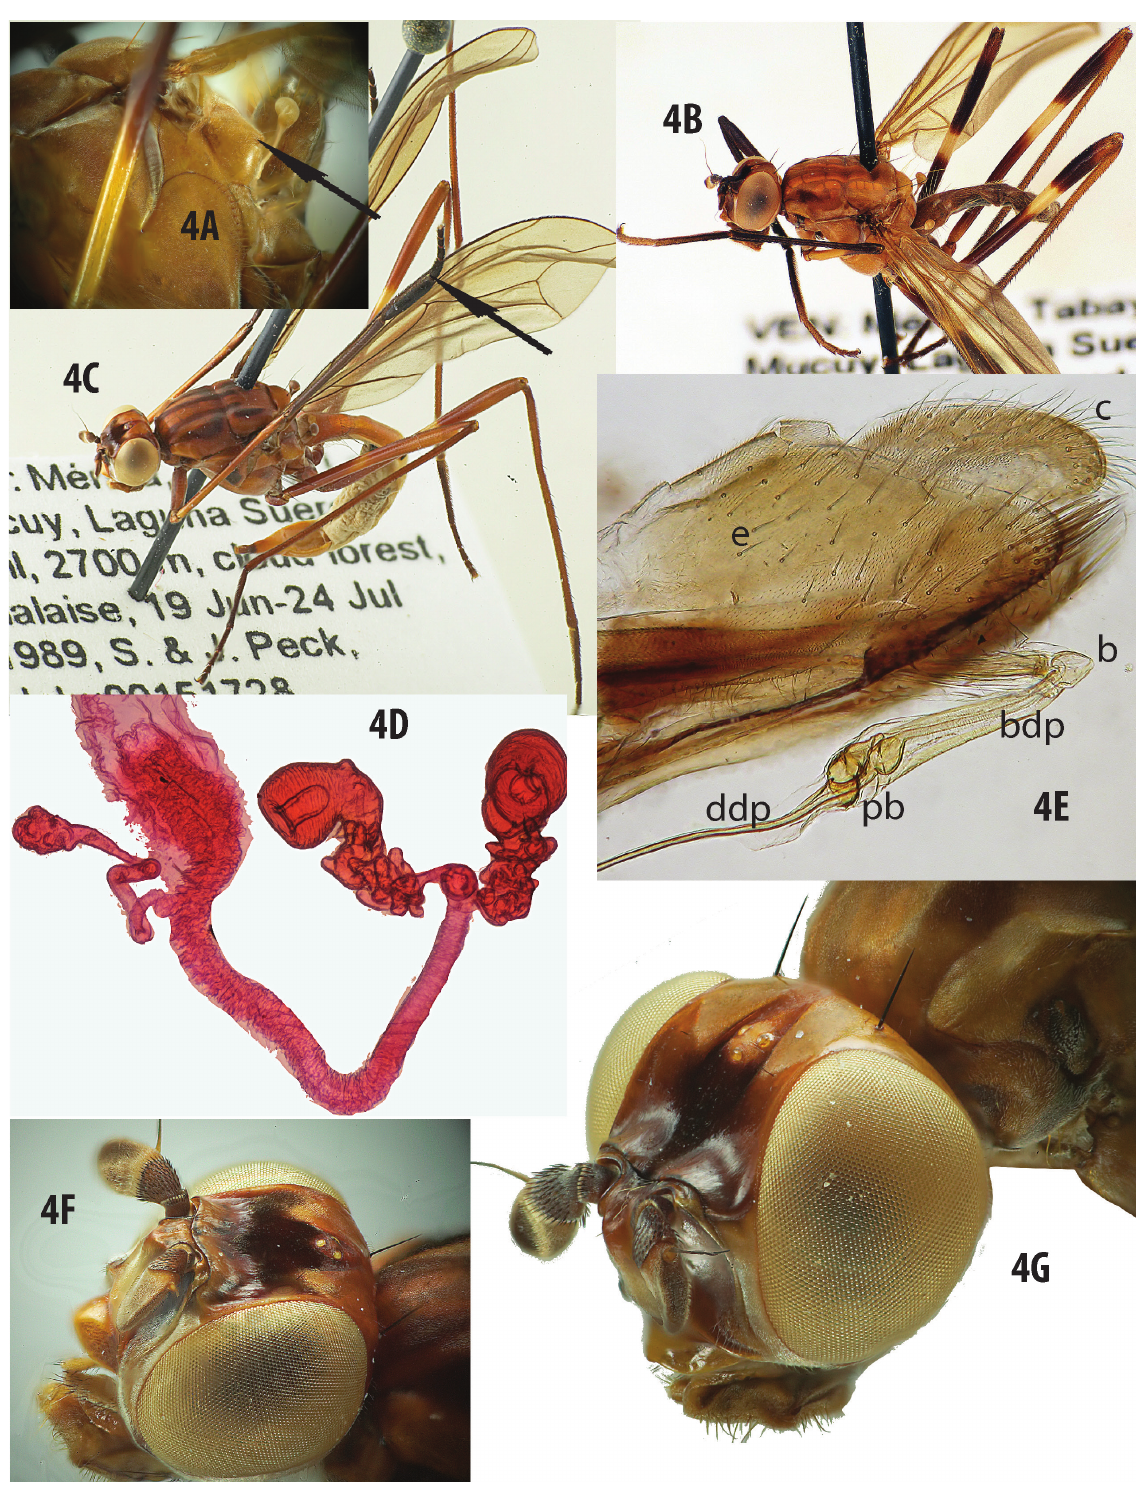
Fig. 4. Mesoconius anchitarsus sp. nov . A . Thorax-abdomen junction to show prominent katatergite (indicated by arrow). B . Paratype ♂. C . ♀. D . Spermatheca and associated structures. E . Male terminalia. F . Head, ♀. G . Head, ♂. Abbreviations: b = basiphallus; bdp = basal distiphallus; c = cercus; ddp = distal distiphallus; e = epandrium; pb = phallic